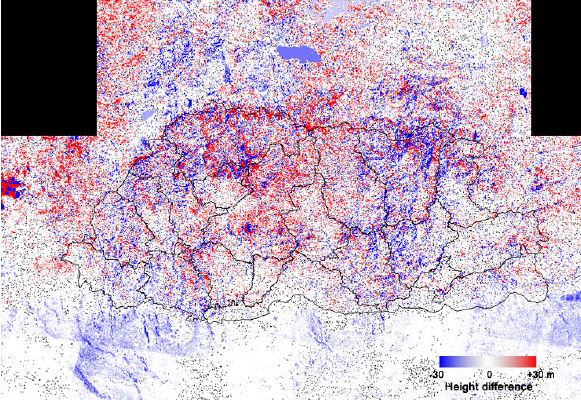
Figure 12. Height difference image of ASTER GDEM-2 minus SRTM-3 in Bhutan. The black lines show administration boundaries as a reference. The void areas of SRTM-3 were not considered in this